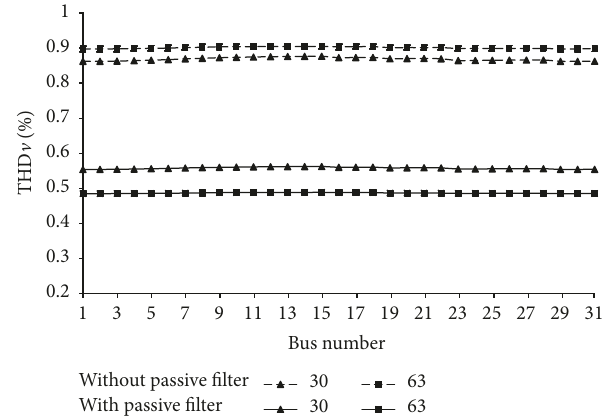
Figure 10: THD 𝑉 at medium voltage for times 30 and 63 with and without passive filter.